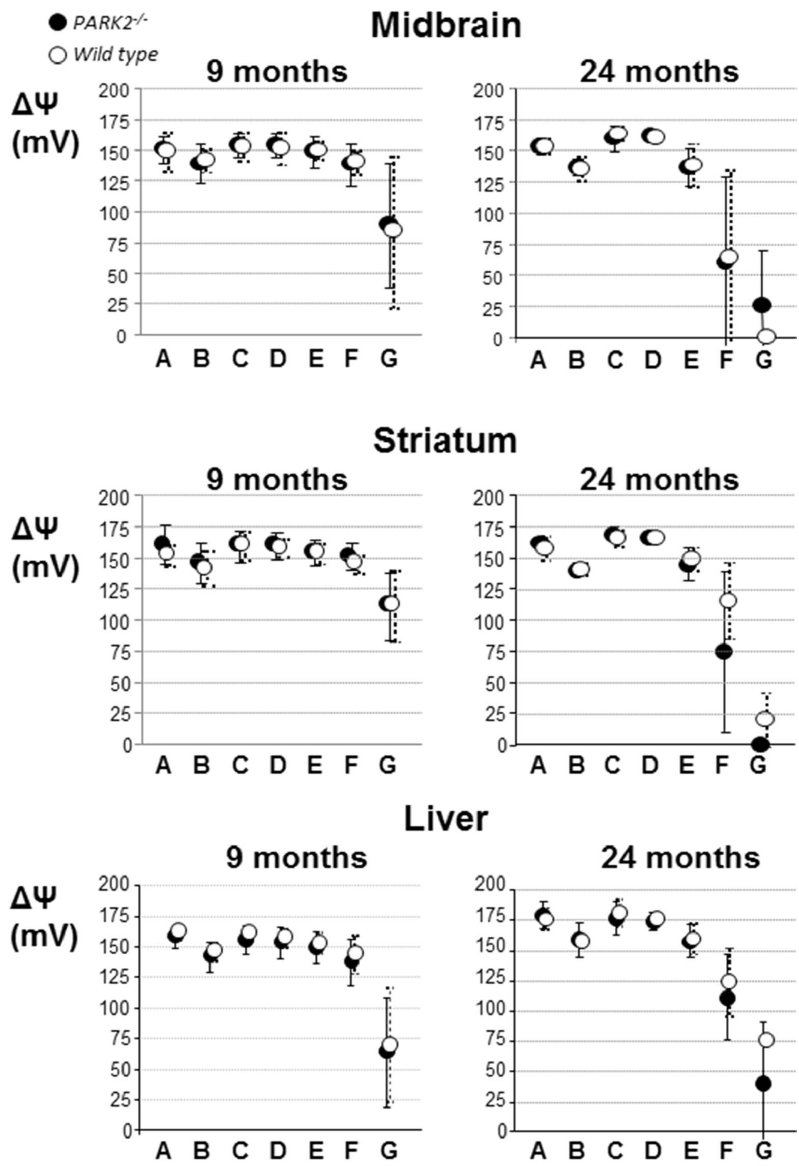
Figure 4. The inner mitochondrial membrane potential is normal in midbrain and striatum of PARK2 2 / 2 mice. Dark circles= PARK2 2 / 2 , white circles=wild type; DY m=inner mitochondrial membrane potential expressed as mV after transformation of the fluorescent rhodamine 123 signal using the Nernst equation, as explained in the methods section; A= DY m in the presence of glutamate + malate; B=A + 1 mM ADP; C=B + 1 m M oligomycin; D=C + 1 m M cccp; E=C + 2 m M cccp; F=C + 4 m M cccp;G=C + 8 m M cccp. The data were obtained in parallel to the analysis of respiration; two animals, one per genotype, were analyzed the same day; the data obtained from seven 9-month-old mice and six 24-month-old ones of each genotype, they are expressed as mean and